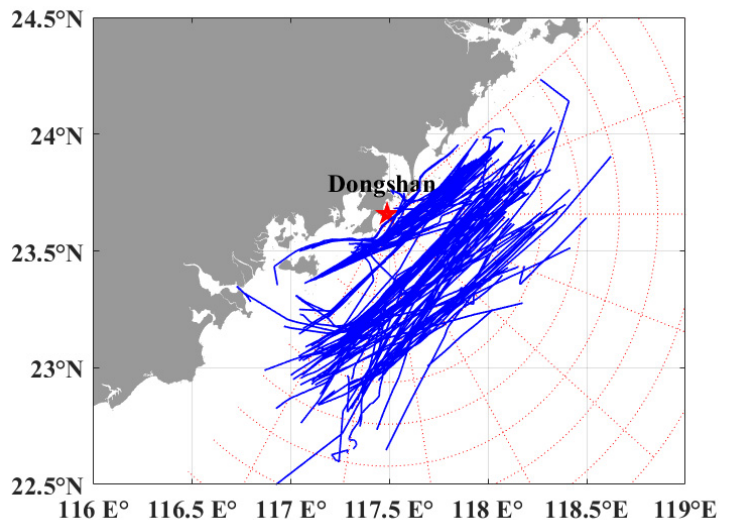
Figure 5. The location of radar site and the tracks of matched ships on 5 October 2015.